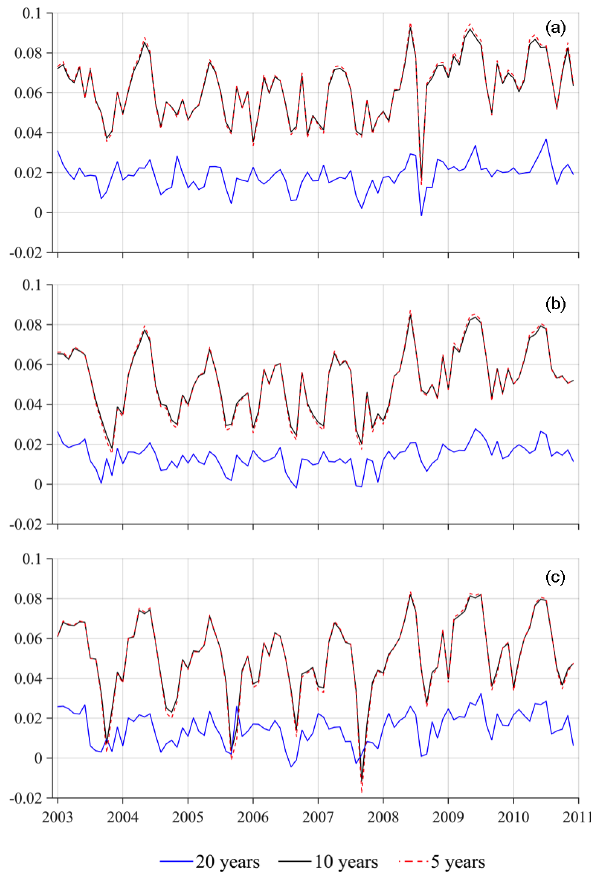
Figure 7. Fraction differences between the TRIX calculated from simulated data using U i and L i values from three recent time series: 20-year (1991–2010, model TRIX 1), 10-year (2001–2010, model TRIX 2), and 5-year (1991–1995, model TRIX 3) data series; and the model TRIX calculated using U i and L i from the 1983–1992 data series. Values are averaged over the three areas (A, B, and